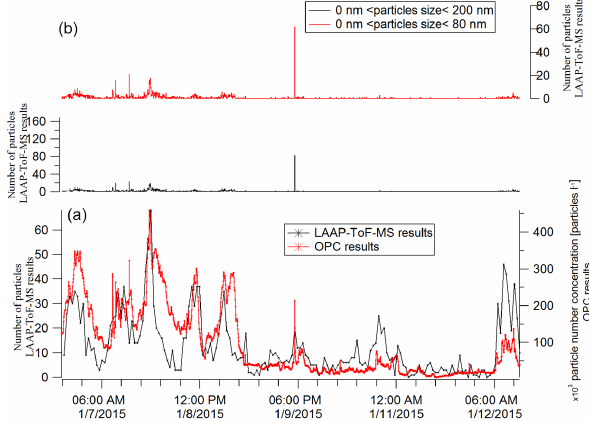
Figure 13. The hit rate and the scattering efficiency of 450nm ferric sulfate particles as a function of the particle number concentration and the percentage of the particles having a size lower than 200nm for different concentrations of generated particles.